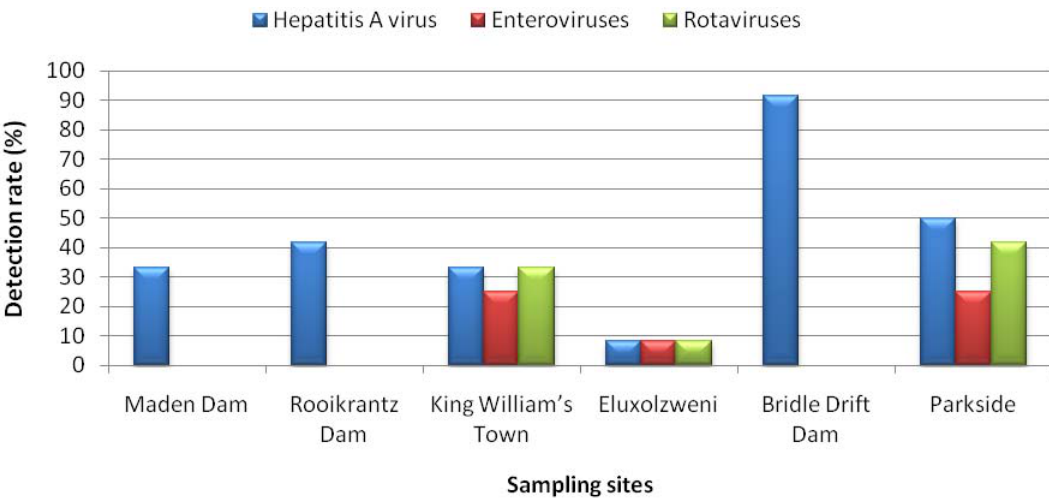
Figure 3. The detection rates for enteric viruses in the Buffalo River and at the six sampling sites along the Buffalo